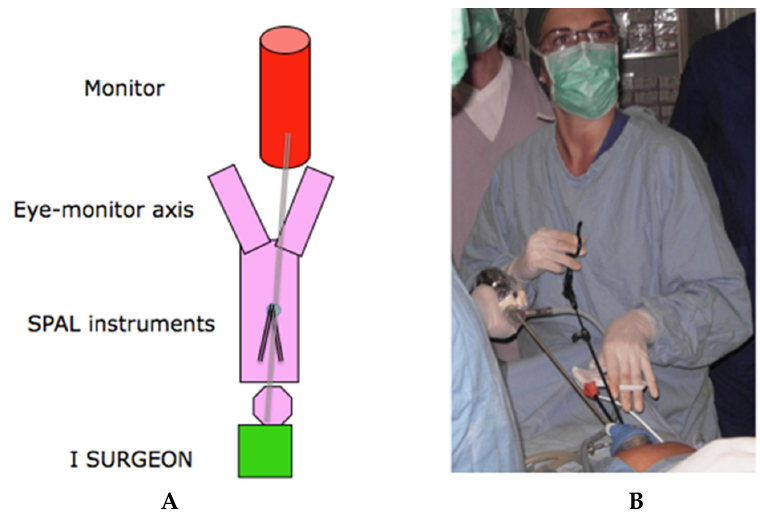
Figure 1. ( A ) Operative room ergonomy. ( B ) First surgeon ergonomy. LESS total hysterectomy follows identical steps of multiport TLH [1]. Bilaterally, the